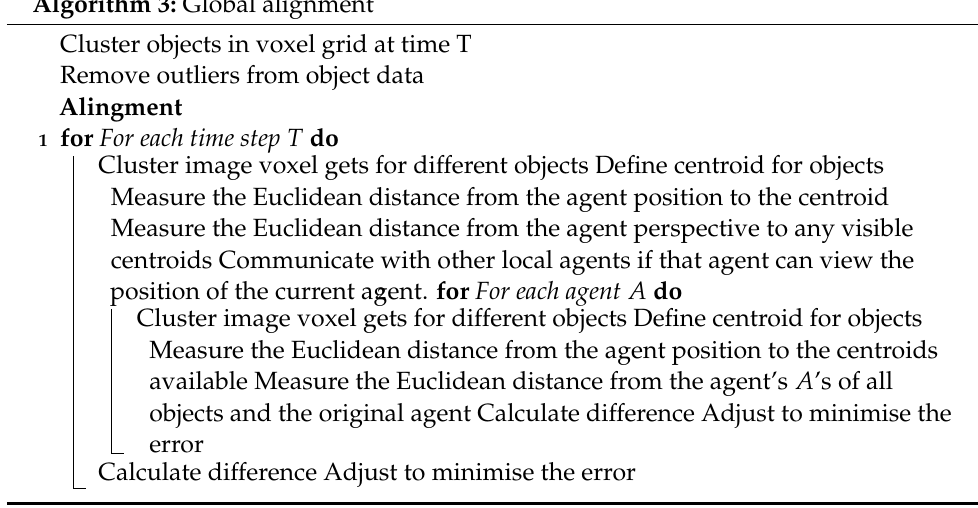
Algorithm 3: Global